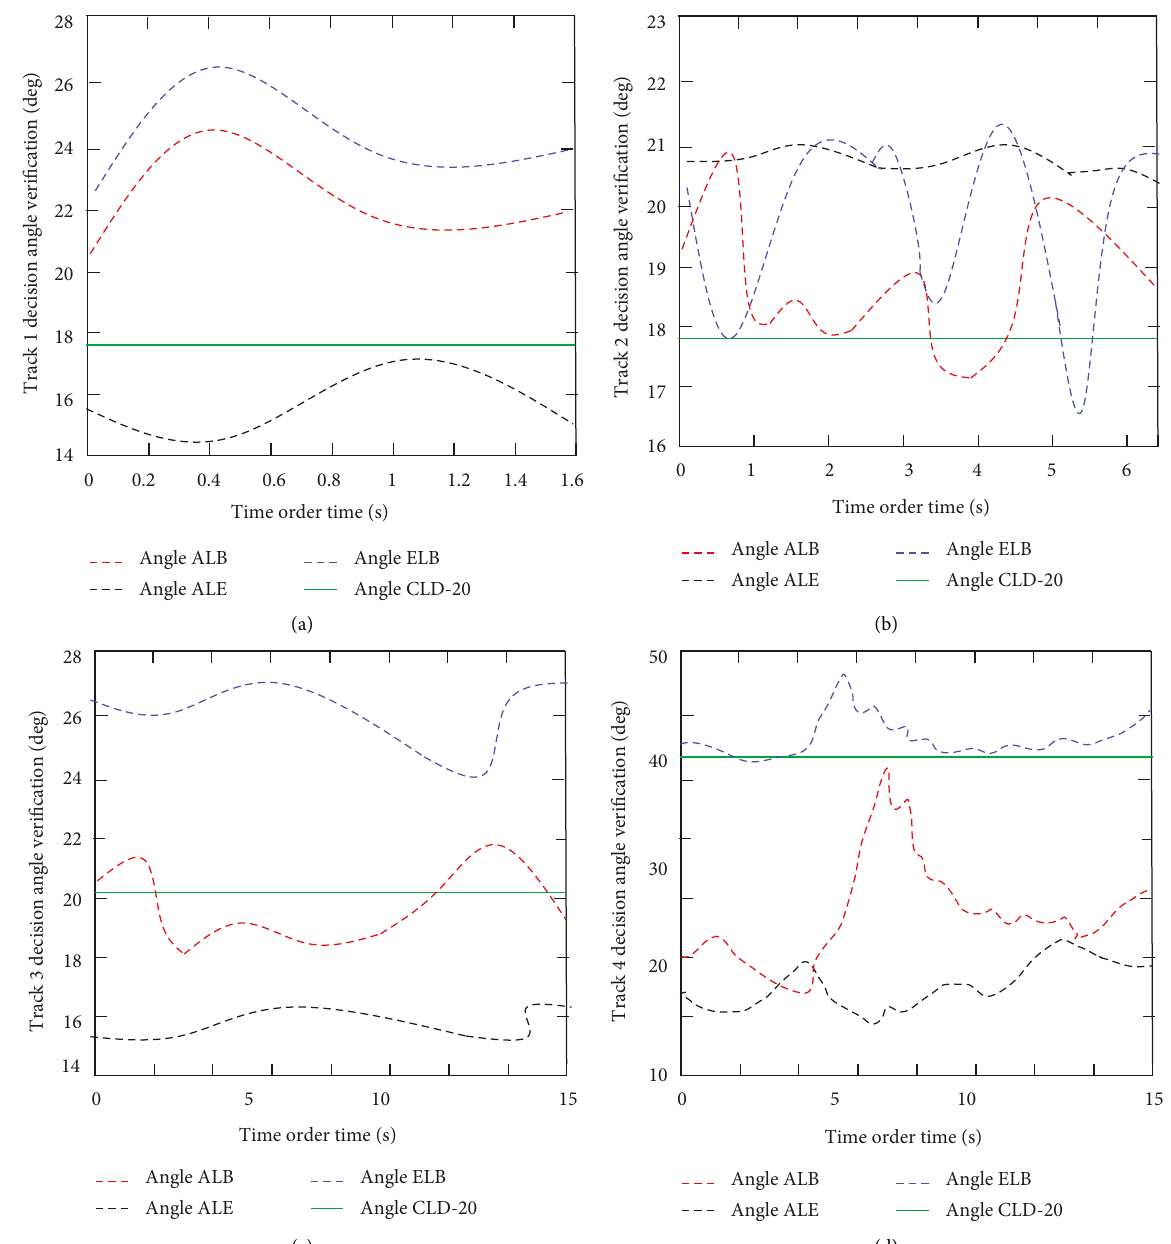
Figure 7: The result of the window angle judgment condition of the end tracking trajectory based on the machine vision